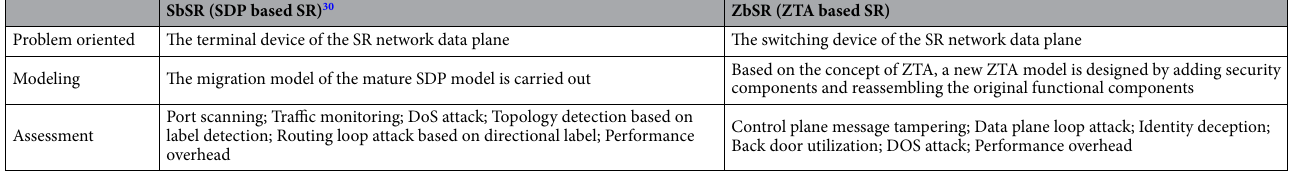
Table 5. Comparison between previous work and this work.